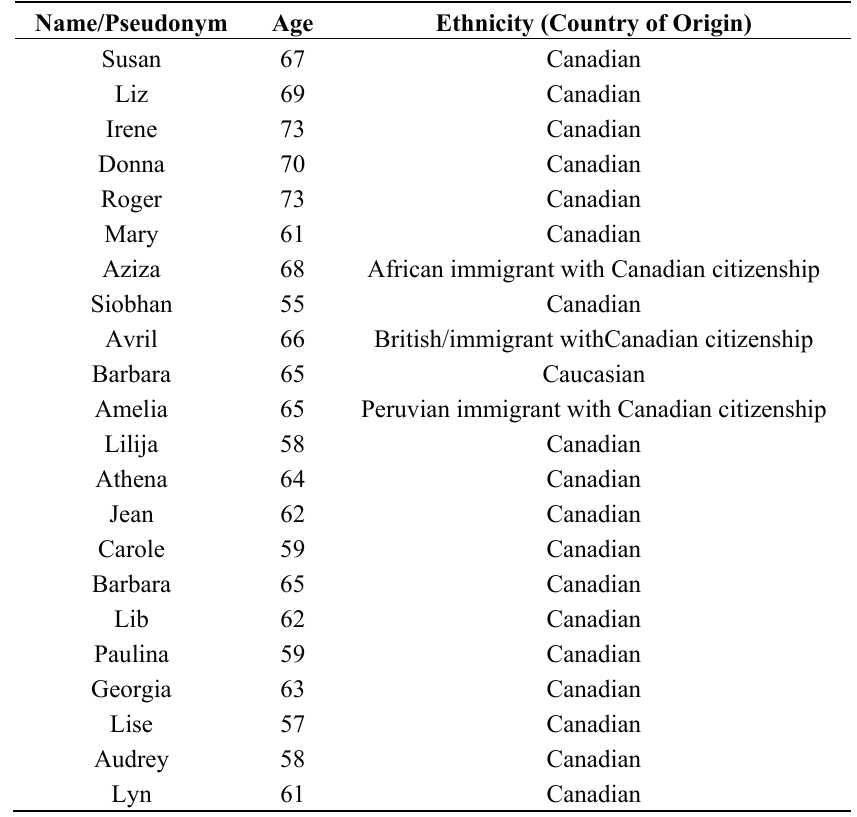
Table 1. Demographic Characteristics of